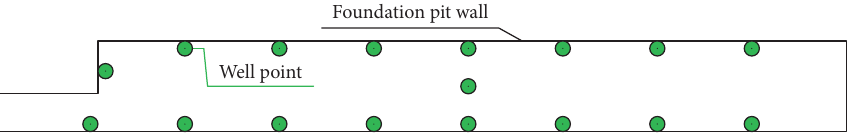
Figure 7: Schematic diagram of the layout of the dewatering